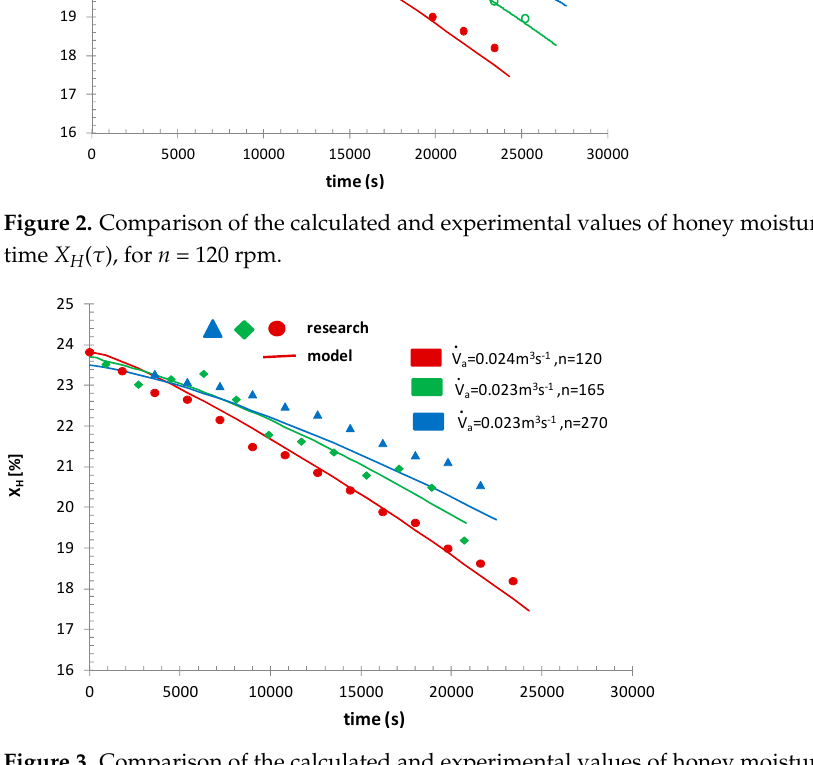
Figure 3. Comparison of the calculated and experimental values of honey moisture as a function of time X H ( τ ), for V a ≈ 0.023–0.024 m 3 s − 1